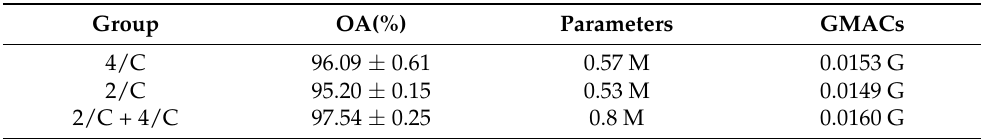
Figure 11. The proposed structure with different groups. ( a ) Structure diagram with channel number C/4. ( b ) Structure diagram with channel number C/2. Comparison results of the proposed structure with different groupings on network